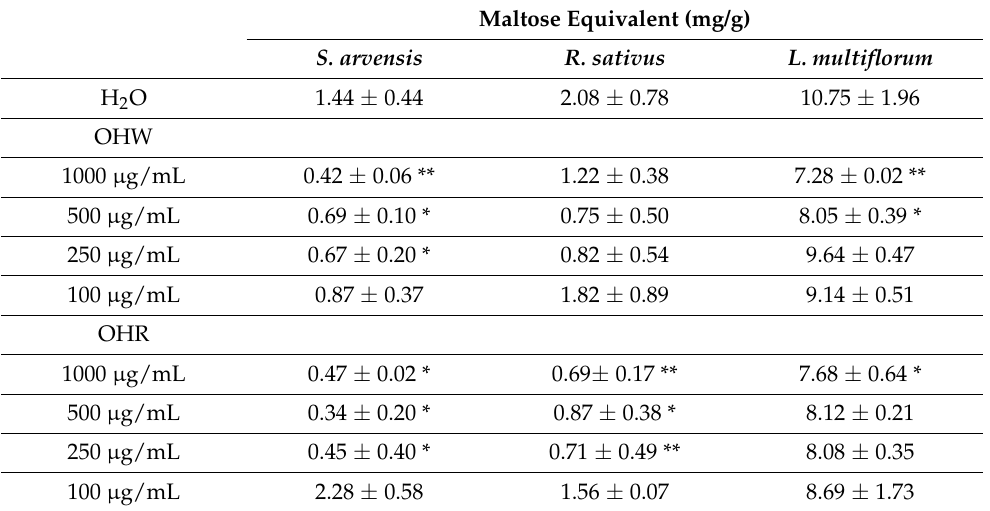
Table 4. Maltose equivalent content of 5 days old seedlings of S. arvensis , R. sativus and L. multi- florum treated with different concentrations of the EOs. Data are expressed as the average of three experiments ± SD.